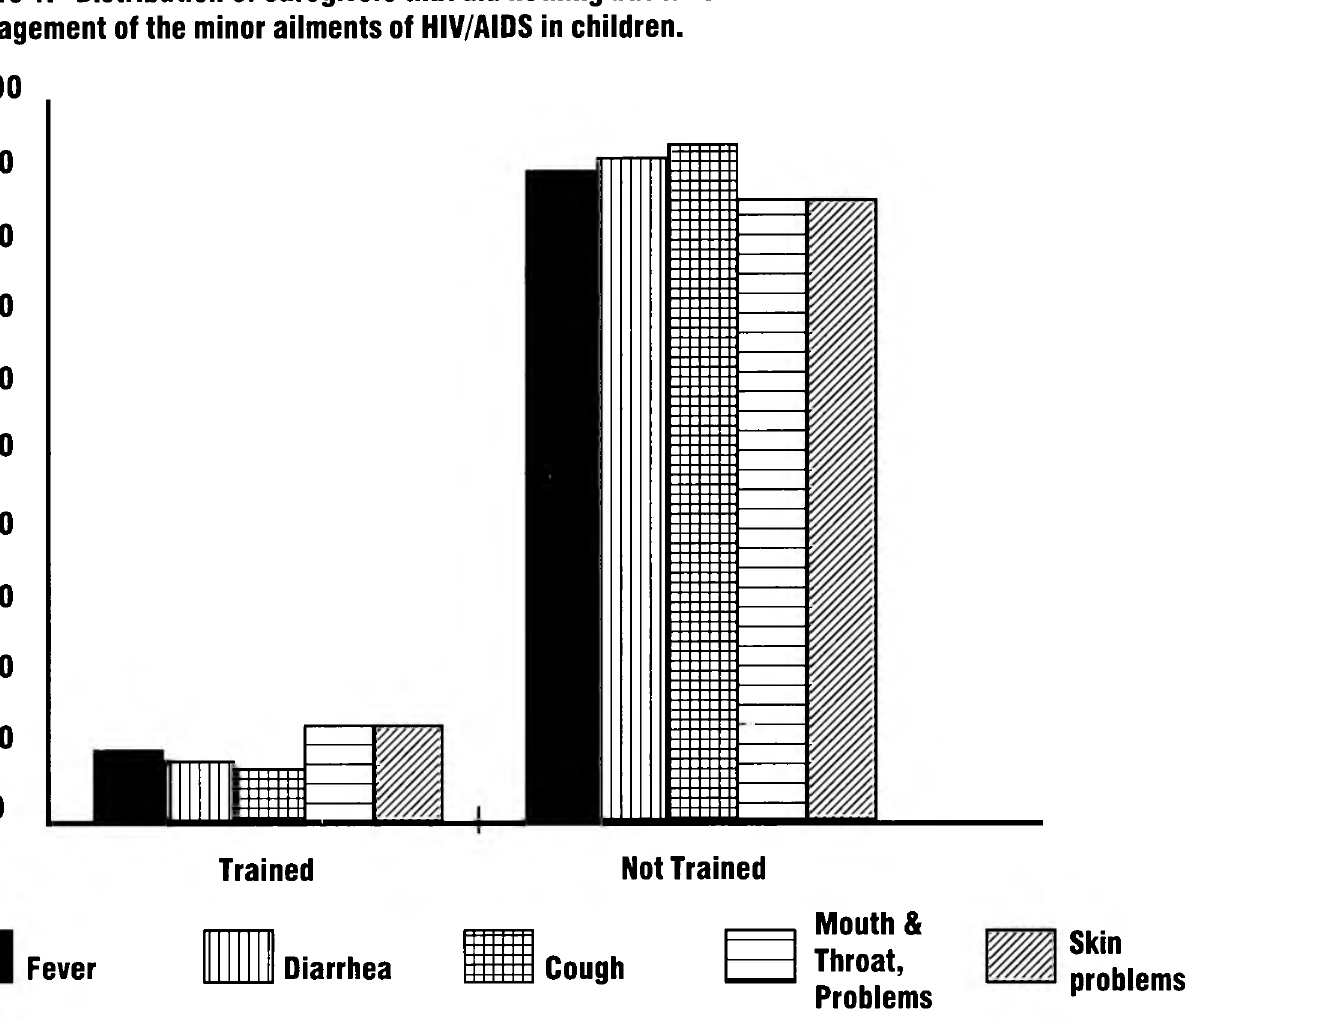
Figure 1 . Distribution of caregivers that did nothing but take the child to the clinic for the management of the minor ailments of HIV/AIDS in